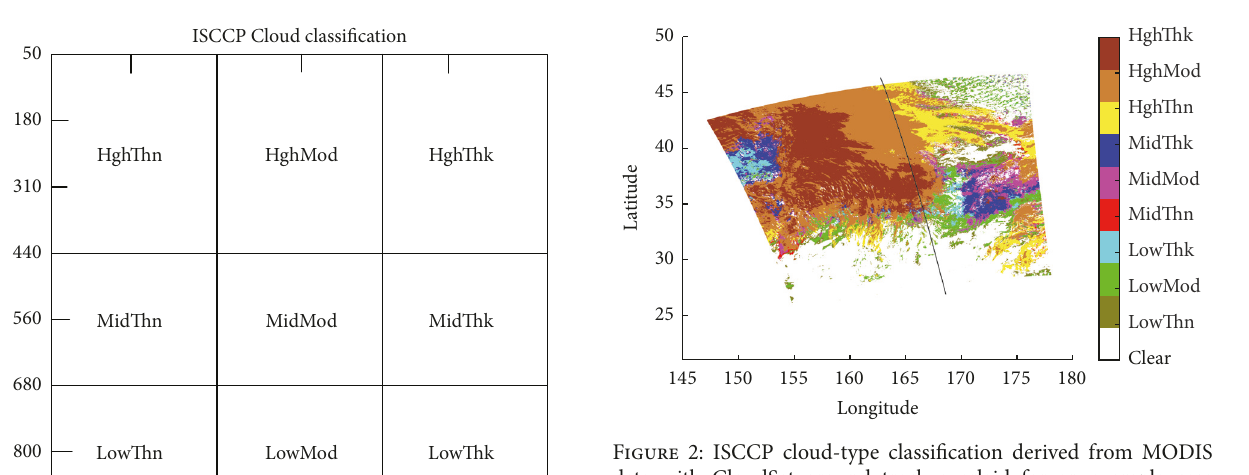
surface-defined cloud types (e.g., cirrus and stratus) do not